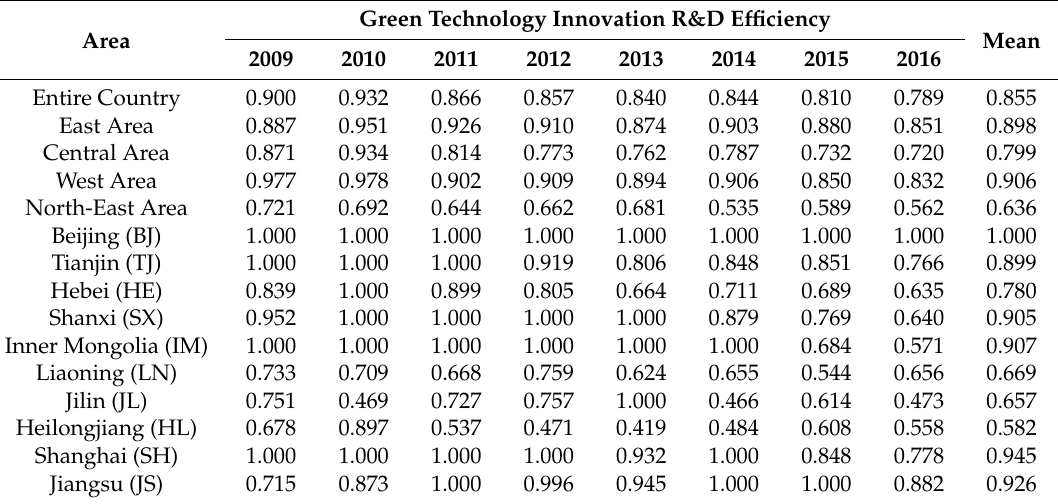
Table 3. China’s industrial enterprises’ green technology innovation R&D efficiency